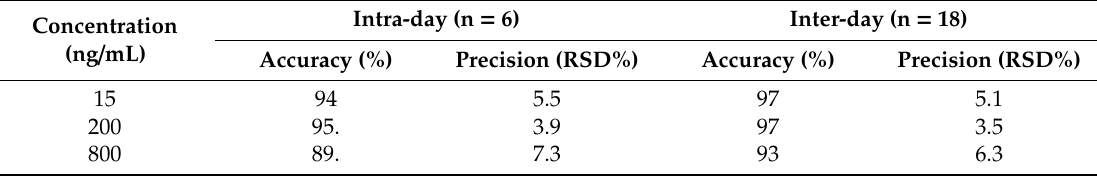
Table 1. Inter- and intra-day precision and accuracy of lekethromycin in rat plasma.